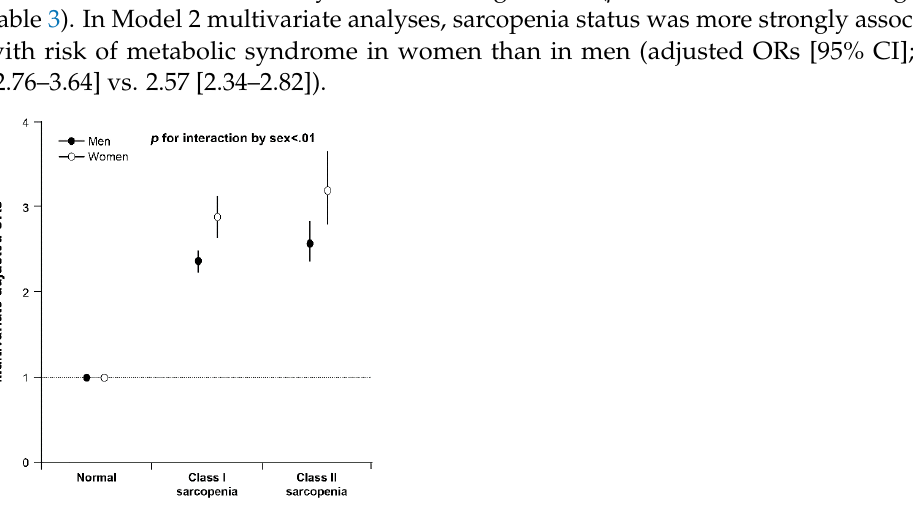
Table 3. Adjusted ORs (95% CI) of metabolic syndrome according to sarcopenia status in study subjects.